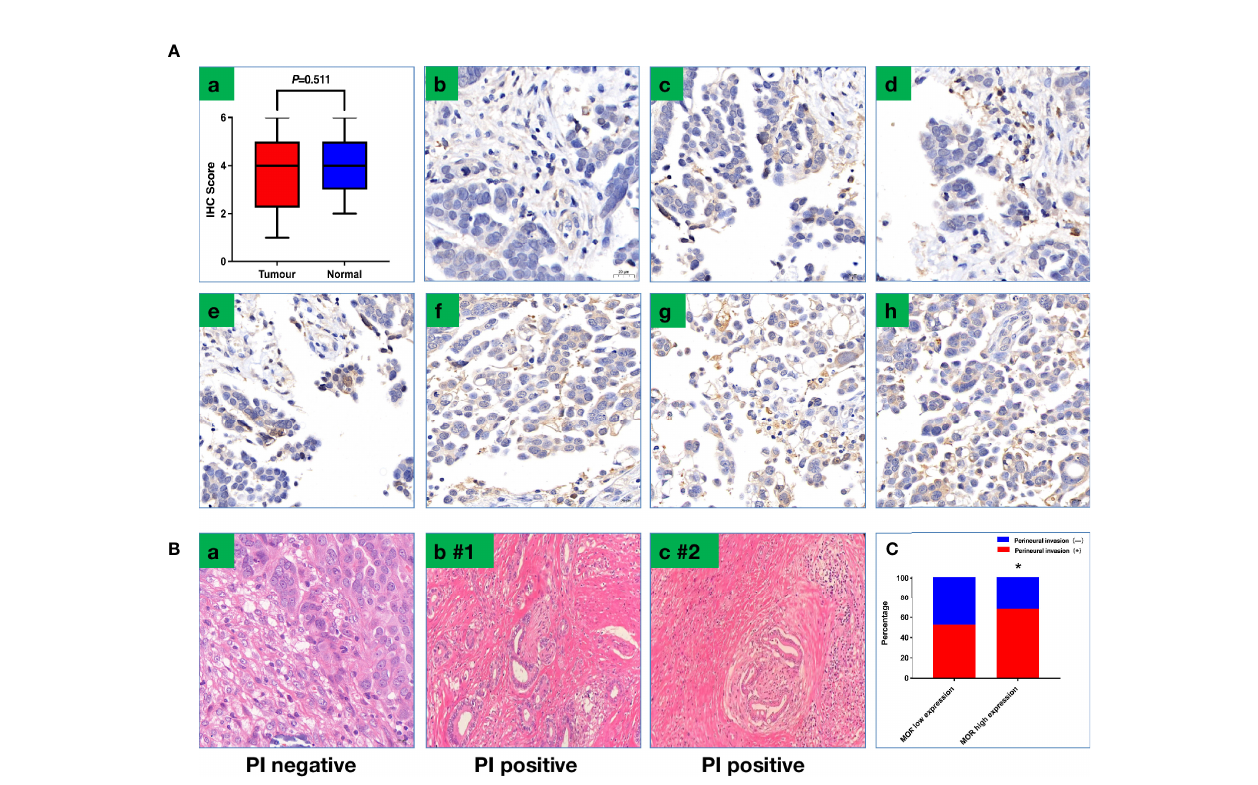
FIGURE 3 | (A) Representative images of IHC to show scoring criteria and MOR expression. (a) MOR expression between tumor tissue and normal tissue; (b) score 0; (c) score 1; (d) score 2; (e) score 3; (f) score 4; (g) score 5; (h) score 6. (B) Representative image to show PNI; PNI was de fi ned as cancer cells that invade the perineural spaces of surrounding nerves (a) PNI negative; (b,c) PNI-positive patients (#1 – 2). (C) PNI positive rate based on MOR expression. PNI, perineural invasion, * P <